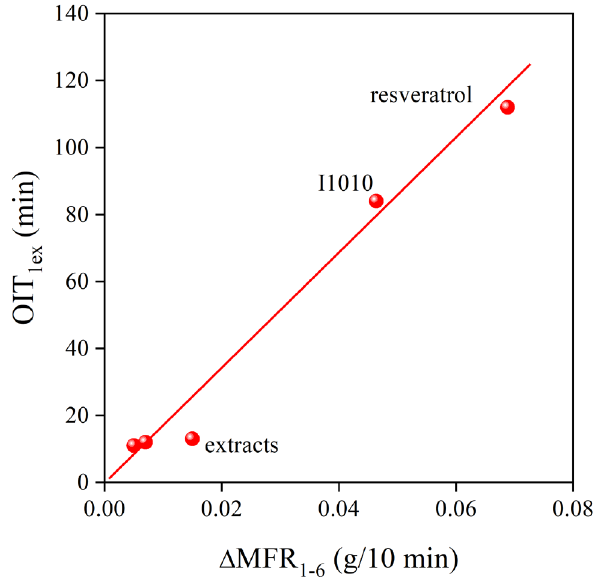
Figure 11. Inverse correlation between the residual and the processing stability of PE stabilized with the reference compounds and the grape peel extracts obtained by different techniques.